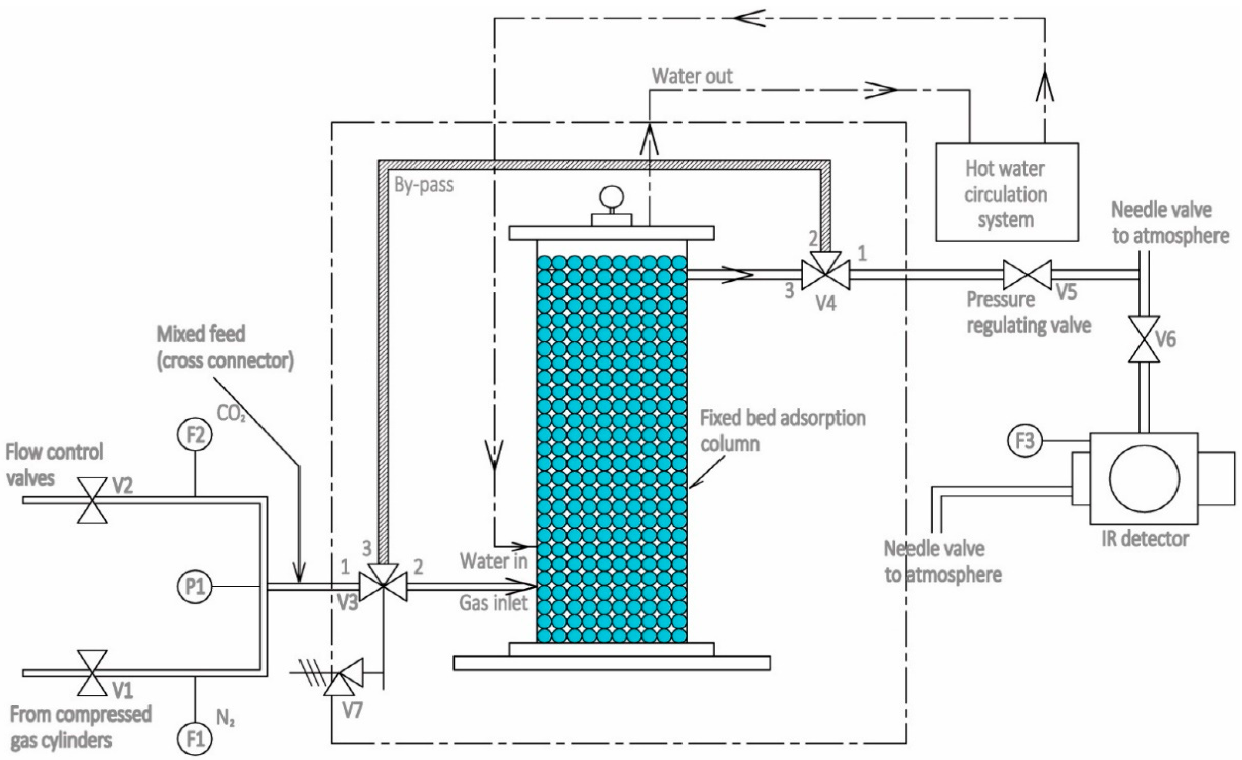
Figure 1. Fixed bed column.